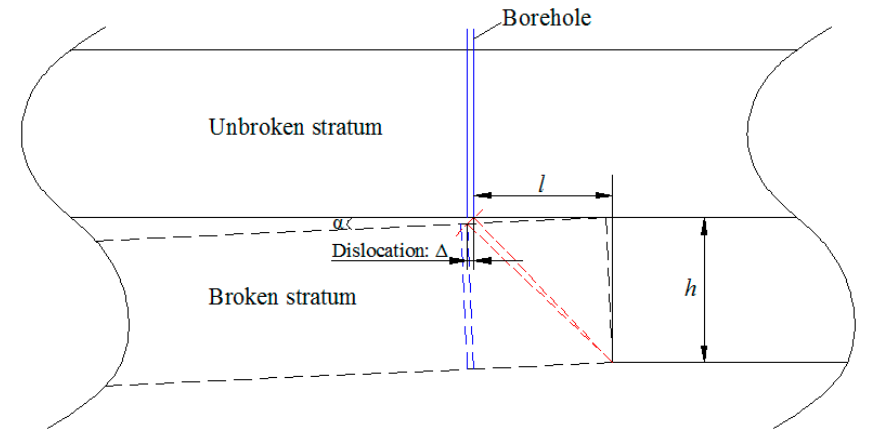
Figure 9. Schematic diagram of the borehole dislocation induced by the deflection of broken strata.